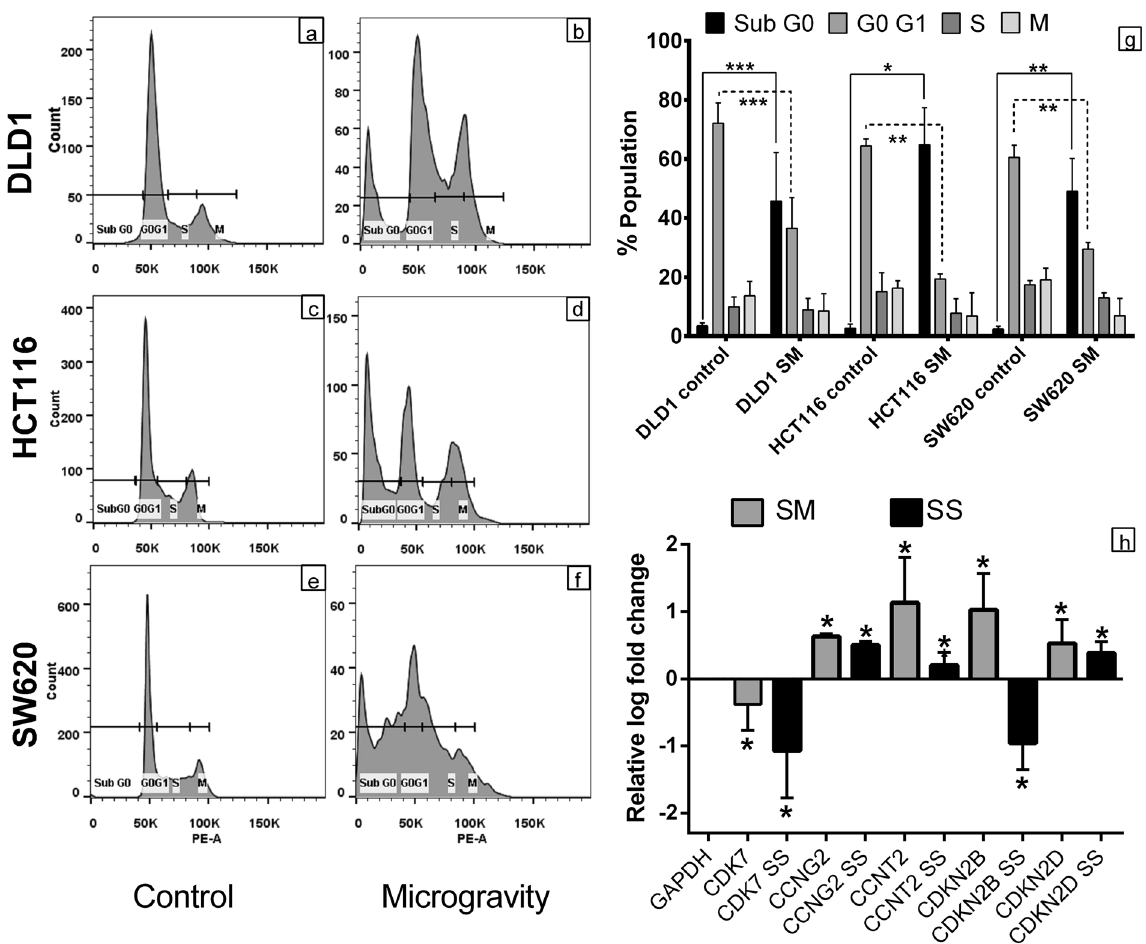
Figure 2. Microgravity significantly increases Sub-G0 population. Microgravity alters Cell cycle in colorectal cancer cells. The individual histogram of the Propidium iodide staining in cells counted through Flow cytometer ( a – f ), shows clear shift towards Sub-G0 population in SM colorectal cancer cells DLD1, HCT116 and SW620 ( b , d,f ) respectively, compared to the respective controls ( a , c , e ). The graphical representation of the population shift during microgravity ( g ) in mean + S.D., Sub-G0 and G0-G1 shift in DLD1 was highly significant P < 0.0005, compared to HCT116 P < 0.05 and SW620 P < 0.005. The experiment was performed a minimum of three times with individual controls. qPCR analysis of Gene expression for CDK7, CCNG2 , CCNT2, CDKN2B and CDKN2D genes between DLD1 cells subjected to SM and shifted to normal (SS) with GAPDH as housekeeping control ( e ), represented in log fold change of mean + S.D. * P < 0.05. The experiments were performed three times with individual